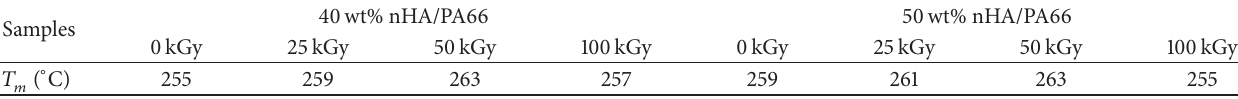
Table 4: The melting temperature of 40wt% nHA/PA66 and 50wt% nHA/PA66 irradiated by different doses.